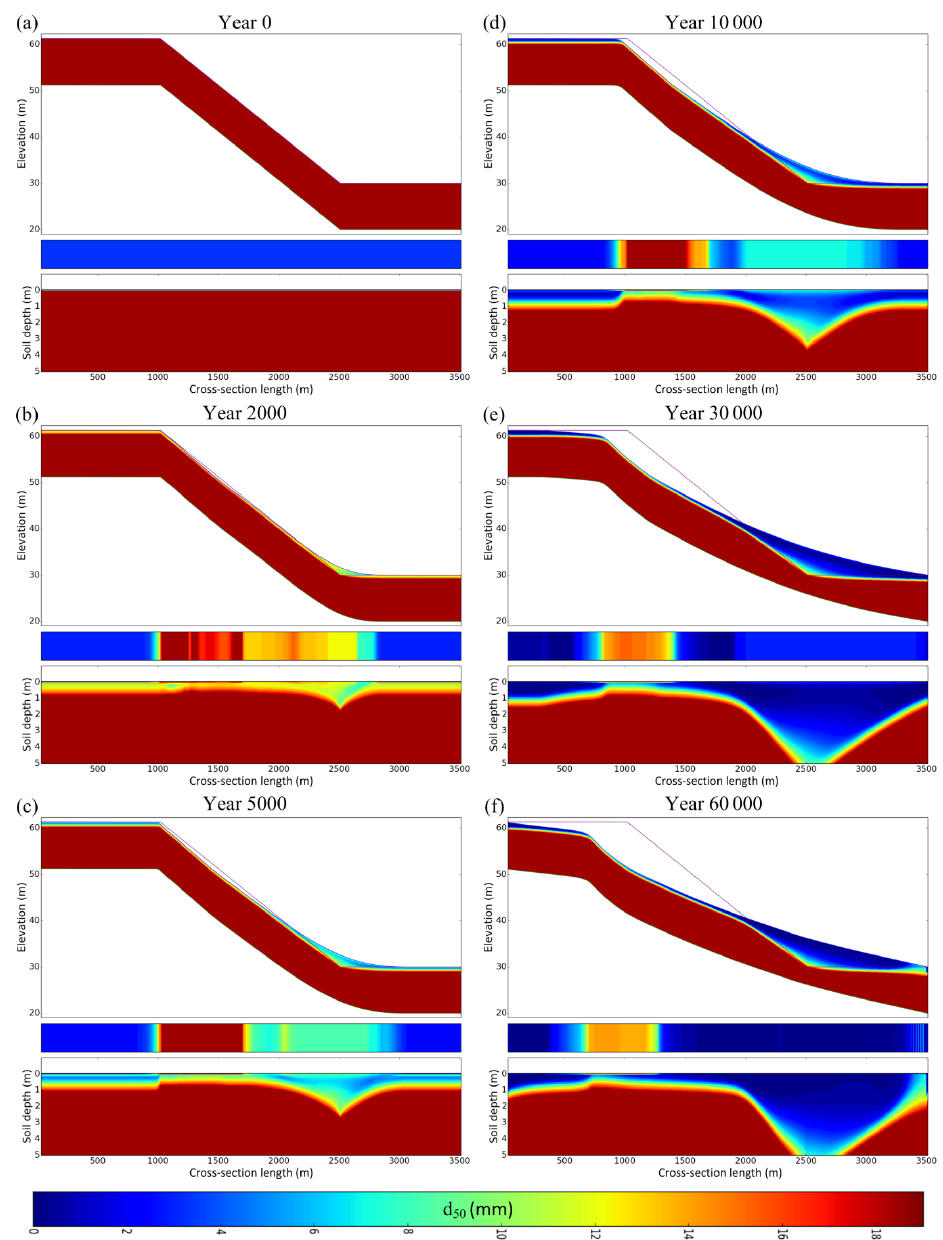
Figure 9. Evolution of the soilscape with the humped exponential depth-dependent weathering